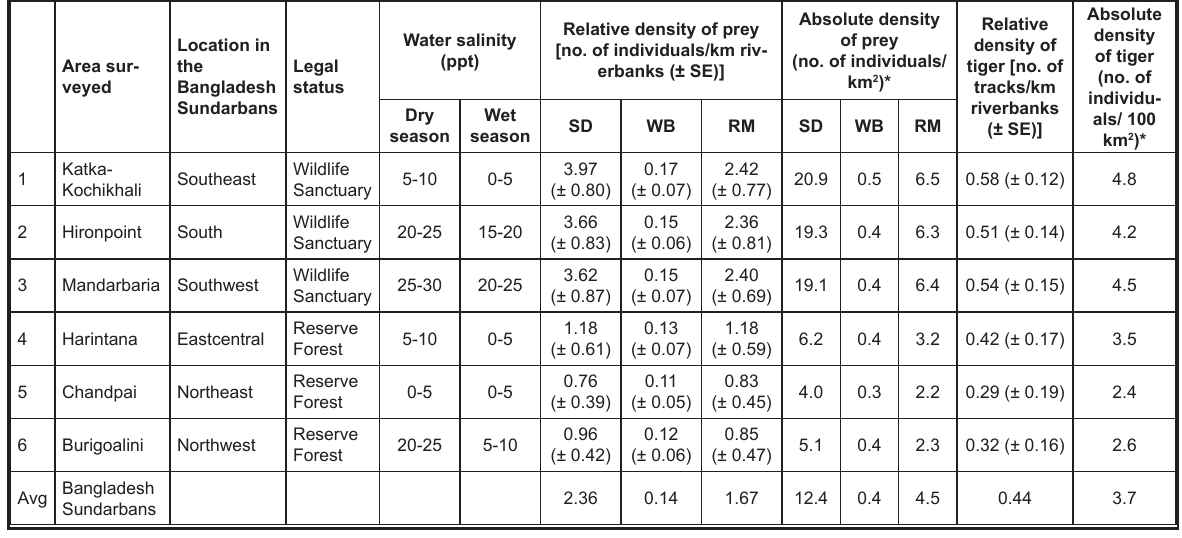
Table 4. Tiger and prey population densities (extrapolated) and indices of abundance in the Bangladesh Sundarbans